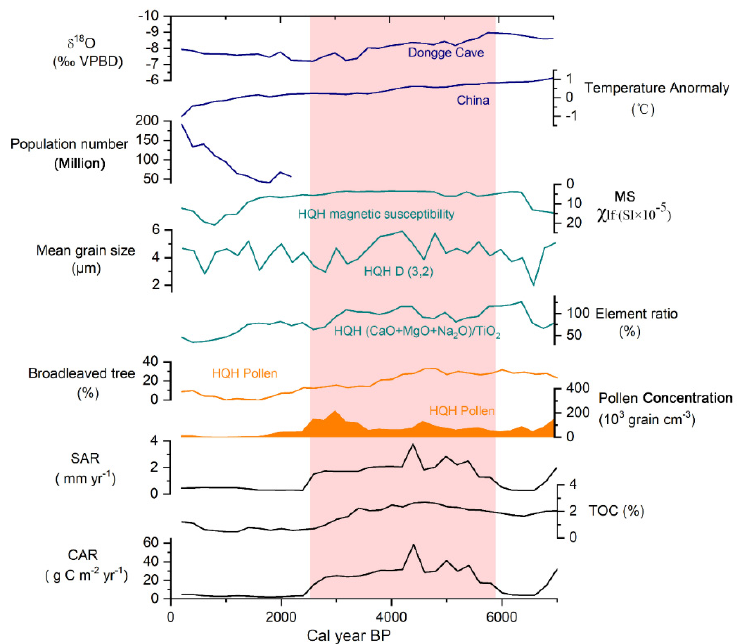
Figure 4. Temporal variation patterns of TOC, SAR, and CAR according to climate ( δ 18 O of caves and temperature anomaly of China), human activities (human populations of northern China), soil erosion (magnetic susceptibility, mean grain size, and element ratio of Huangqihai Lake), and vegetation parameters (broadleaved tree and pollen concentration of Huangqihai Lake). These data